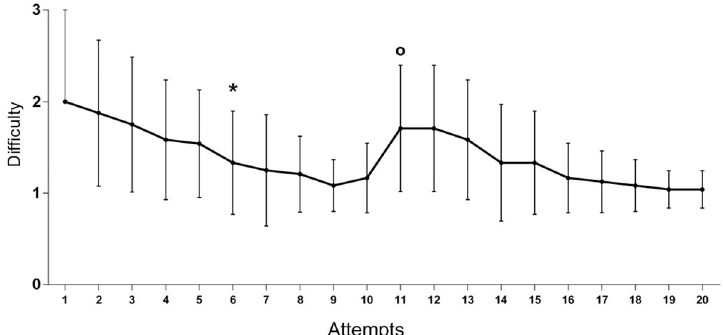
Fig 6. Learning curve for the variable ‘difficulty’. Median and standard error of the difficulty scores (1 = mild; 2 = moderate; 3 = difficult) reported by the 24 operators regarding the laparoscopic-guided kidney biopsy procedure throughout the attempts. ( � ) Moment when subsequent evaluations of variable ‘difficulty’ were stabilized—plateau; (˚) Moment of residual return of the variable ‘difficulty’.